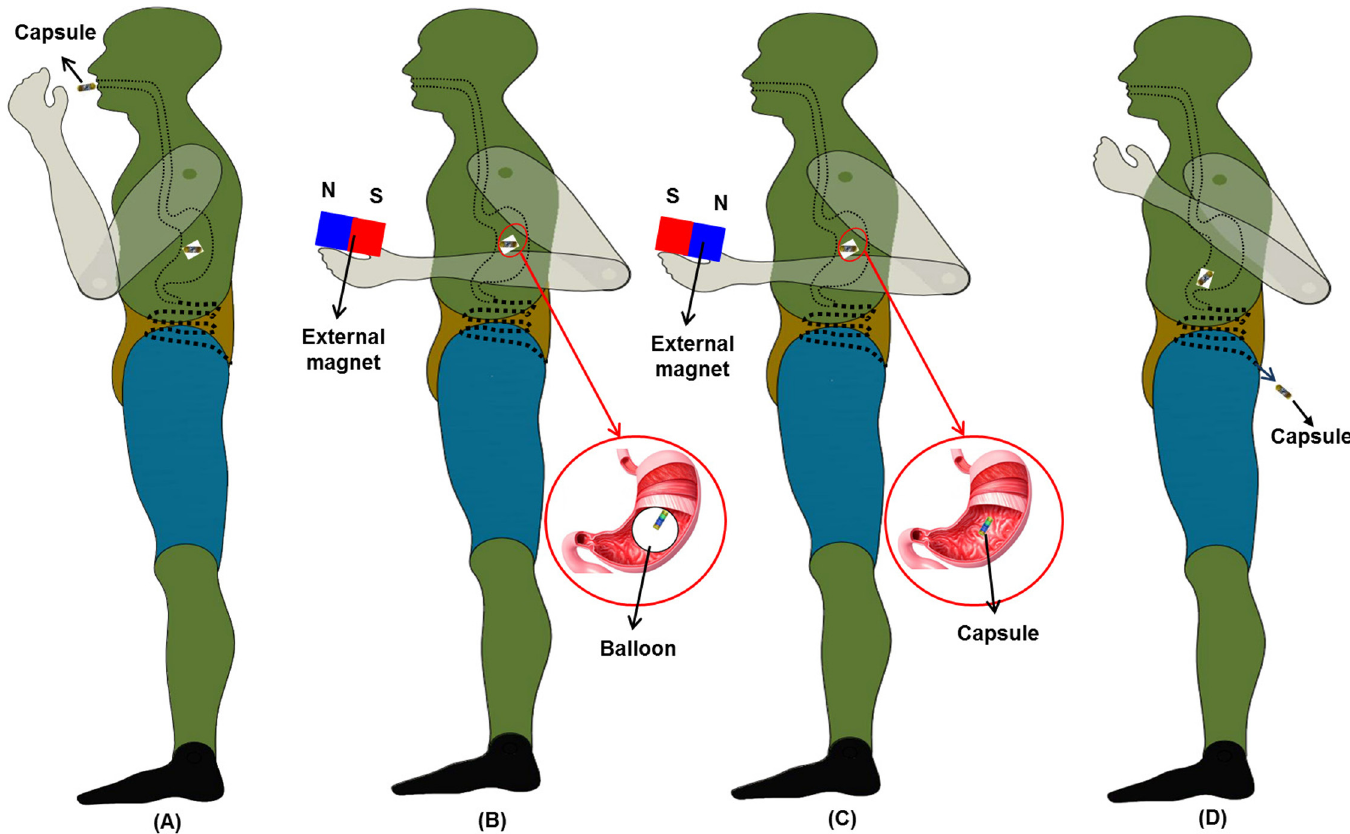
Fig 1. Four main stages for using the MWCE: (A) Swallow stage; (B) Inflation of the balloon; (C) Deflation of the balloon; (D) Excretion of the capsule out of the patient ’ s